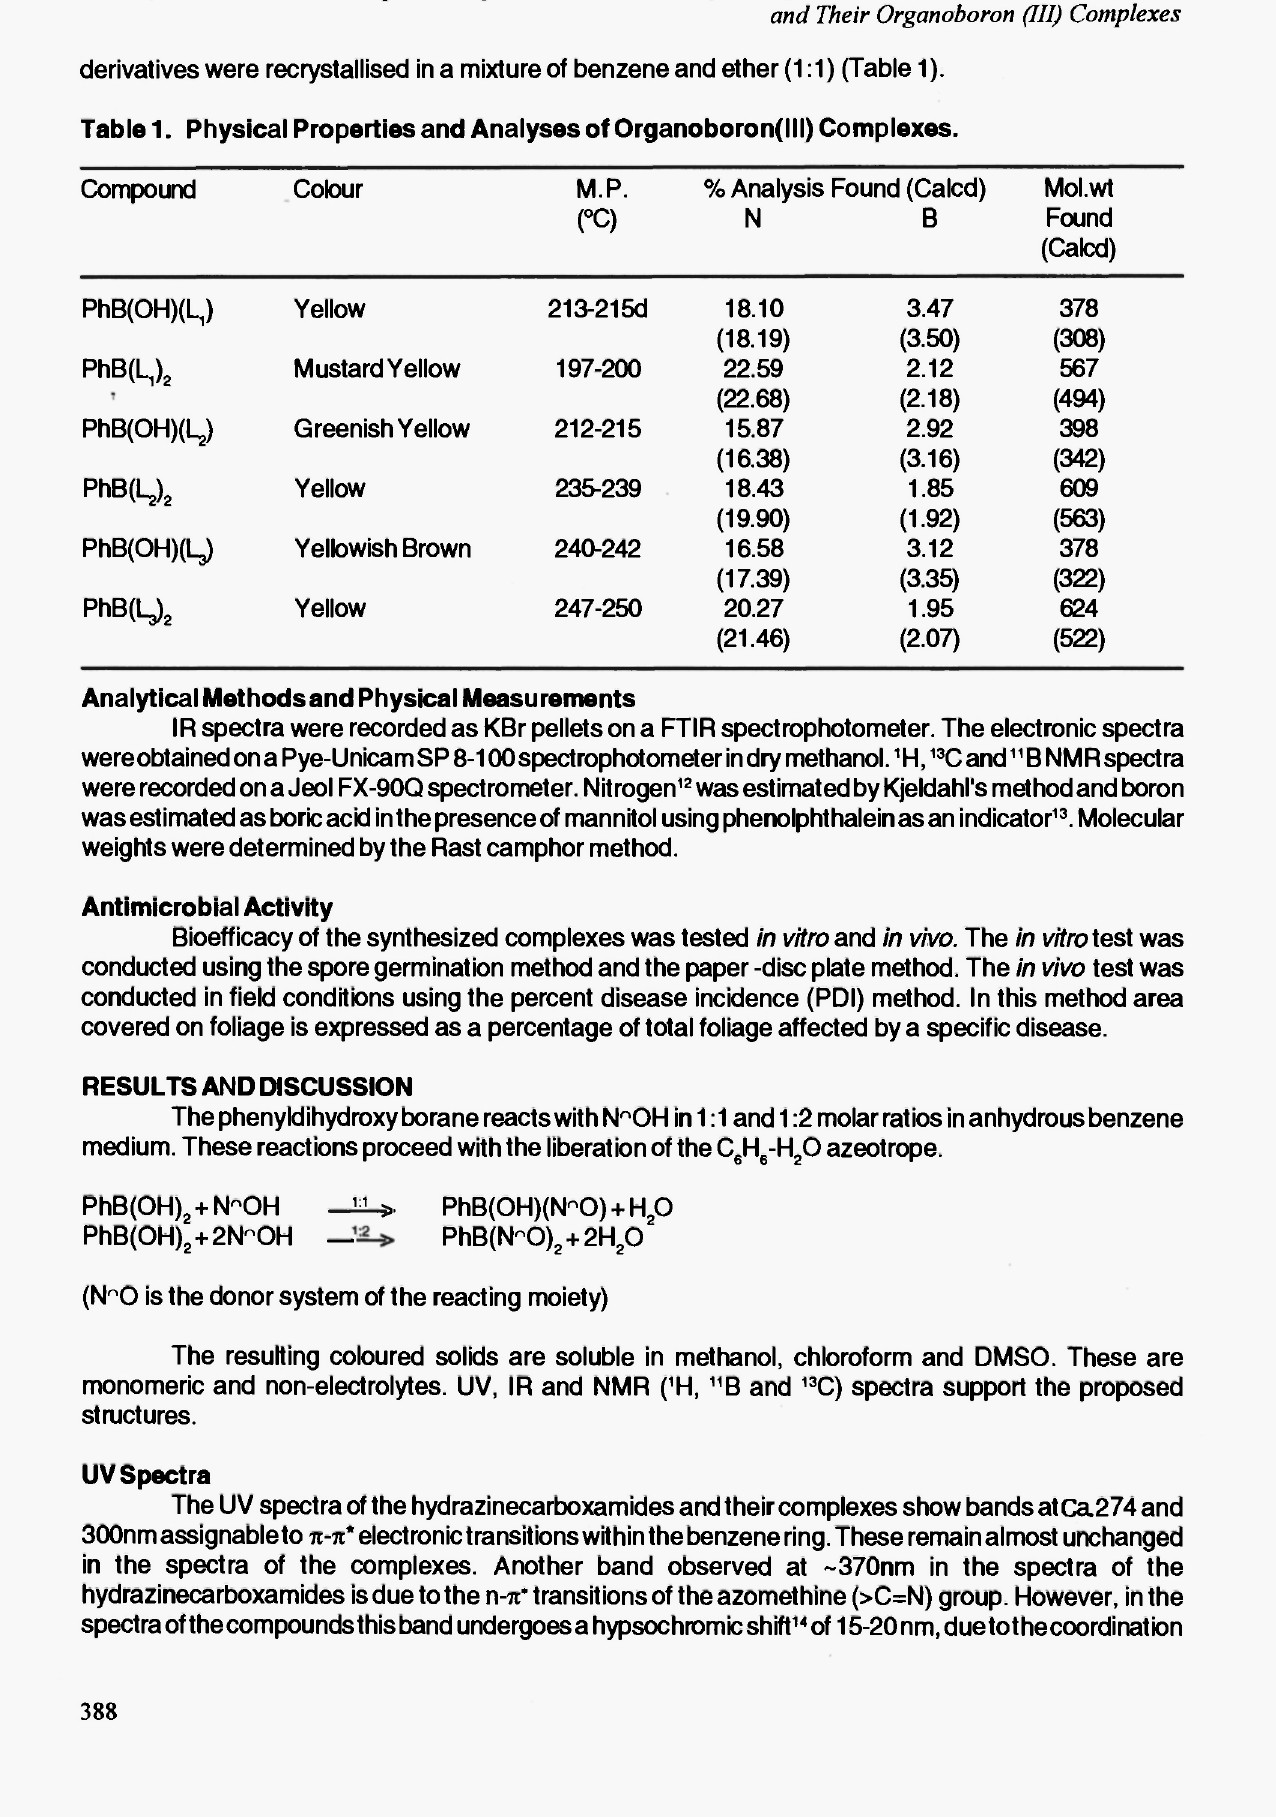
Table 1. Physical Properties and Analyses of Organoboron(lll) Complexes.